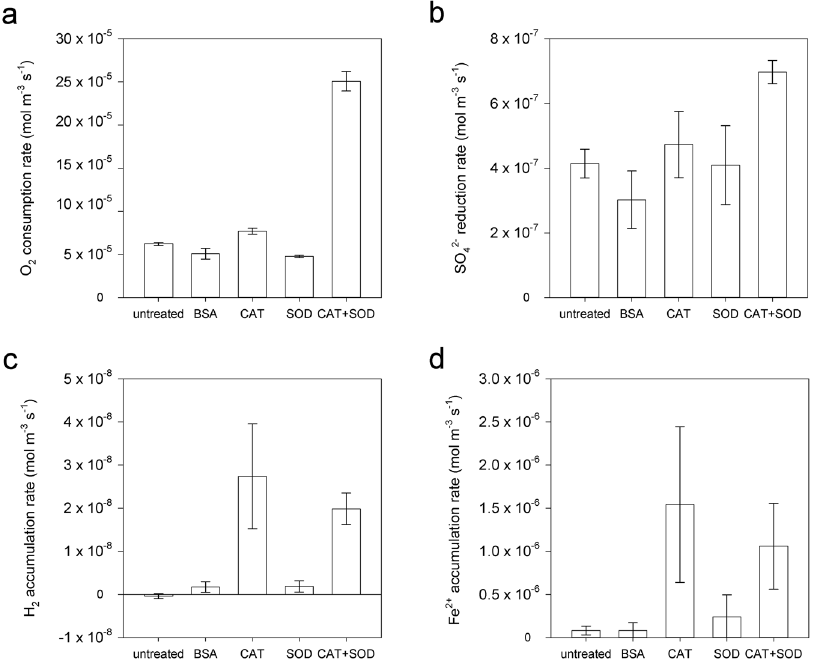
c hydrogen (H 2 ) accumulation, d ferrous iron (Fe 2+ ) accumulation. Sulfate reduc- tion, hydrogen accumulation, and Fe 2+ accumulation rates were calculated for the anoxic period of the incubation. Error bars represent the standard error of the